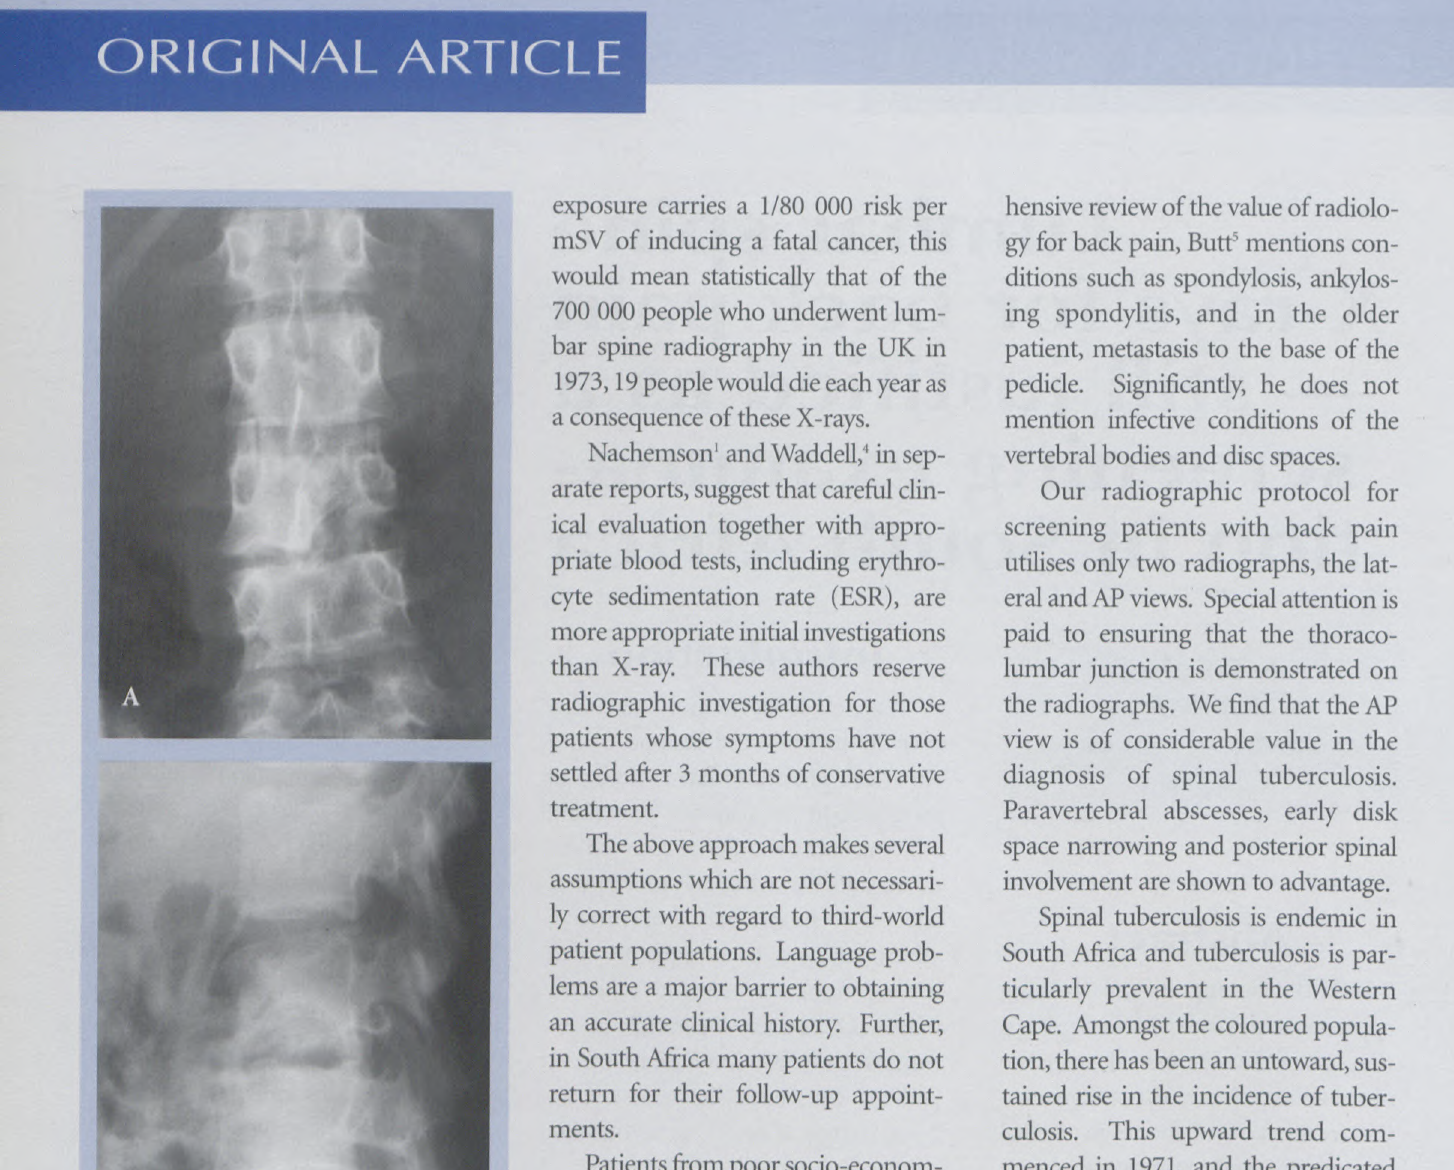
Fig. 1a, b. AP and lateral views of the lumbar spine showing destruction of the vertebral body of L3 with narrowing of the L3-4 disk space due to spinal